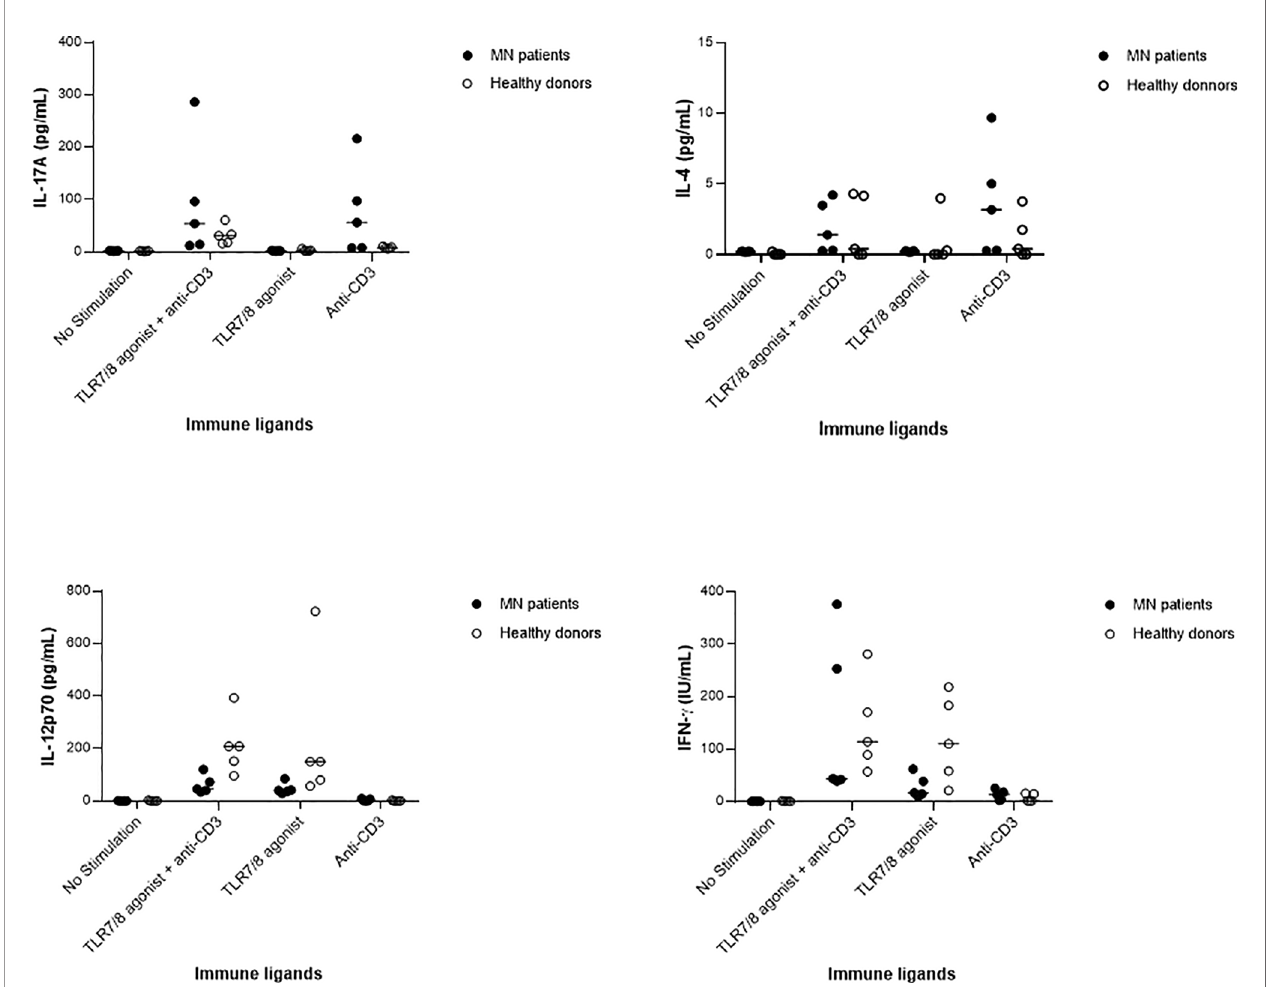
FIGURE 1 | Serum cytokine levels in fi ve membranous nephropathy (MN) patients and fi ve healthy donors after in vitro stimulation of immune cells by anti-CD3, or TLR 7/8 agonist, or both anti-CD3 and TLR 7/8 agonist, or no stimulation. In both MN patients and healthy donors, the cytokines IL-17A and IL-4 were produced upon stimulation by anti-CD3, IL-12p70 as produced upon stimulation with TLR7/8 agonist, and the production of IFN- g as increased after the stimulation of both innate and T